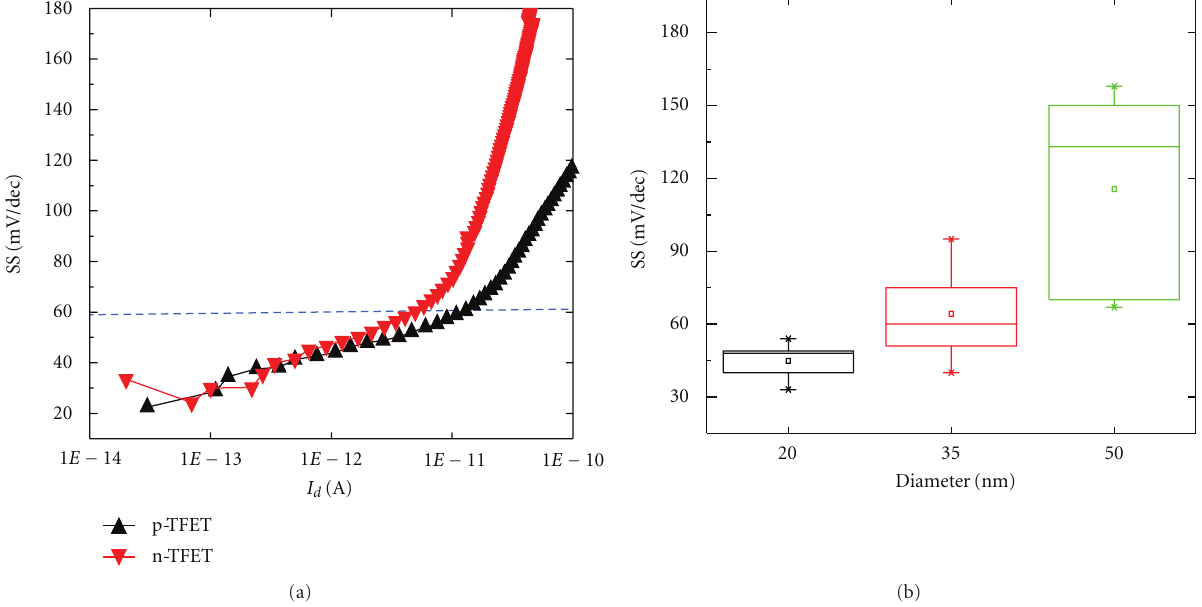
Figure 10: (a) SS versus I d for TFETs. p-TFET exhibits sub-60mV/decade swing for 3 decades of I d , while n-TFET maintained sub- 60mV/decade for more than 2 decades of I d ( V ds = 0 . 1V). (b) SS variations on nanowire diameter of p-TFETs. SS increases as NW diameter gets